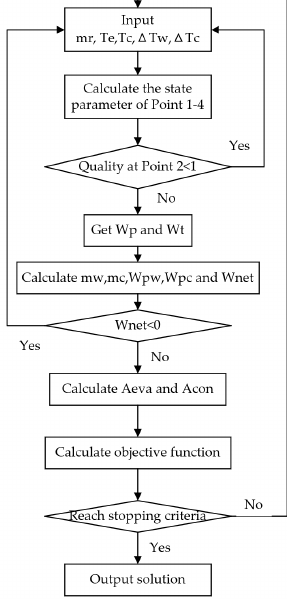
Figure 3. Calculation flowchart of the Matlab program.